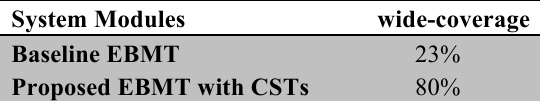
Table 7. Wide-Coverage Comparison